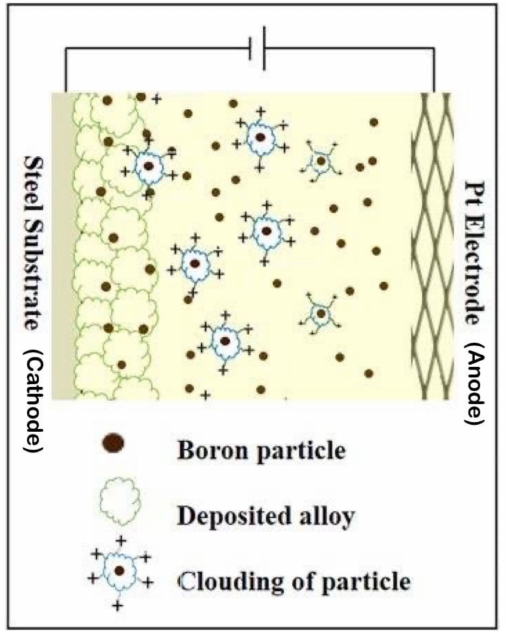
Figure 1. Schematic representation of the boron co-deposition on the base Ni–W alloy